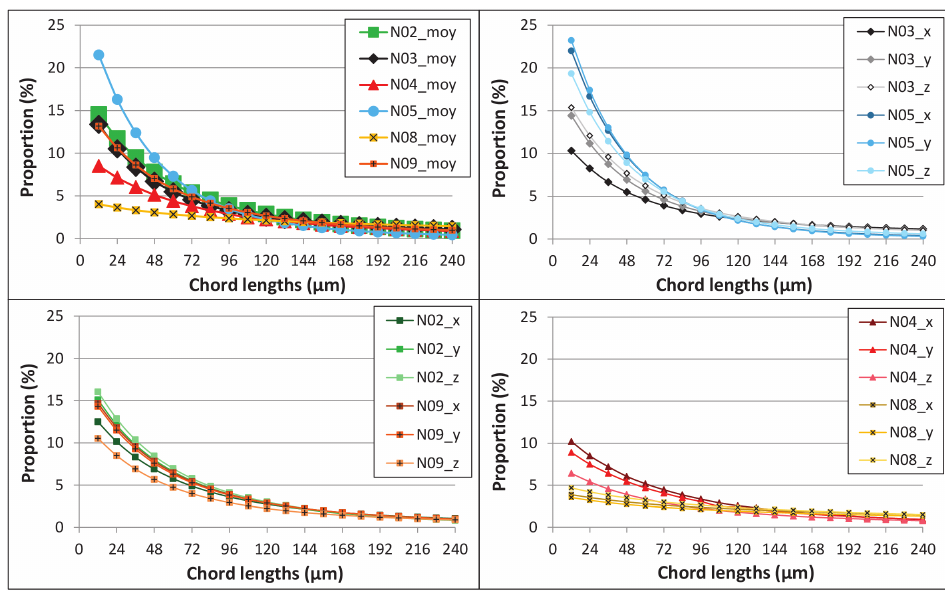
Figure 6. Chords length distribution for Normandie samples, pore diameters are displayed by proportion. On the top left, an average of chord lengths in the three directions is shown. The rest detail chord lengths in directions X, Y and Z: on the top right, there are N03 and N05, on the bottom left, N02 and N09, while on the bottom right, there are N04 and N08.